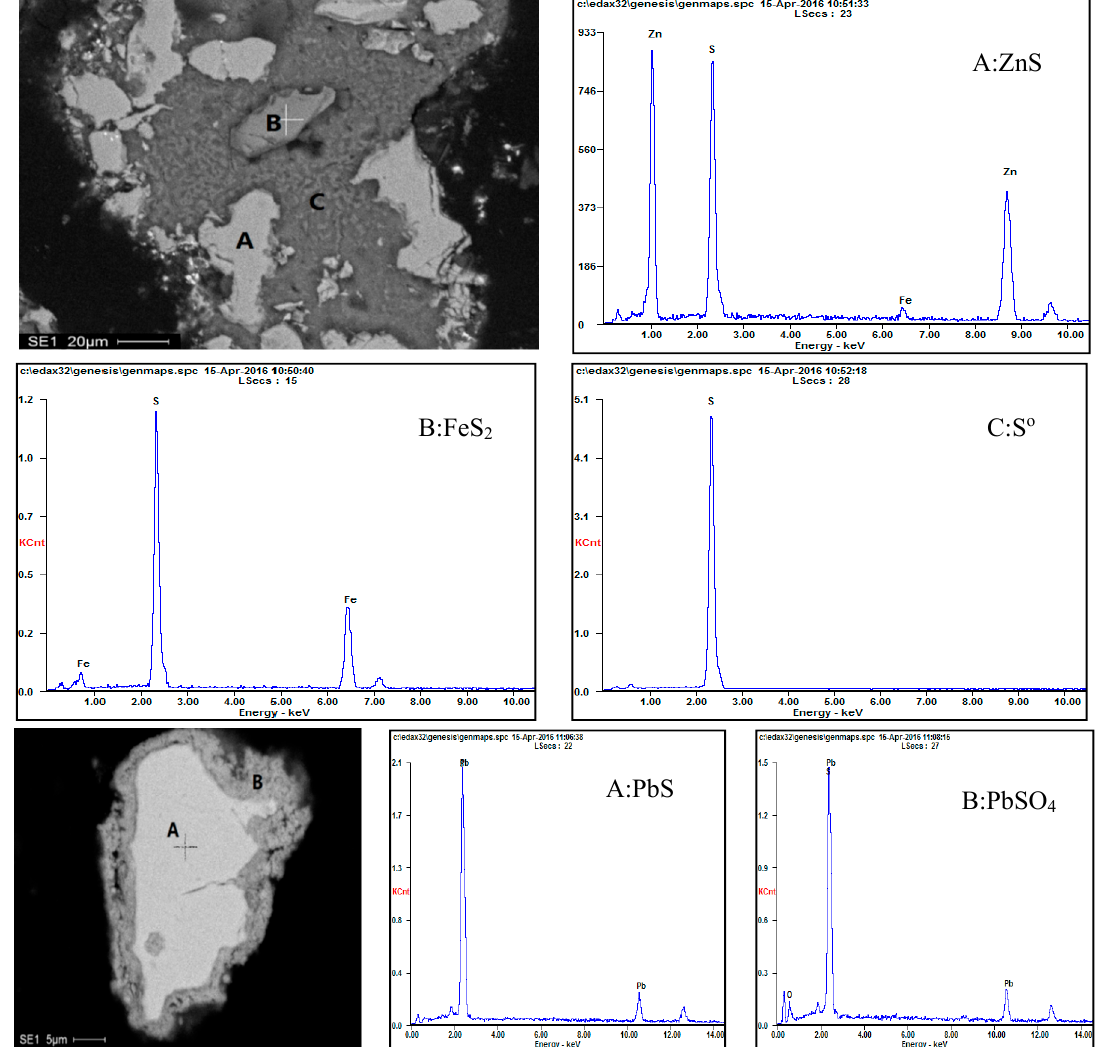
Figure 18. SEM and EDS spectra for the leach residue obtained at 150 °C.